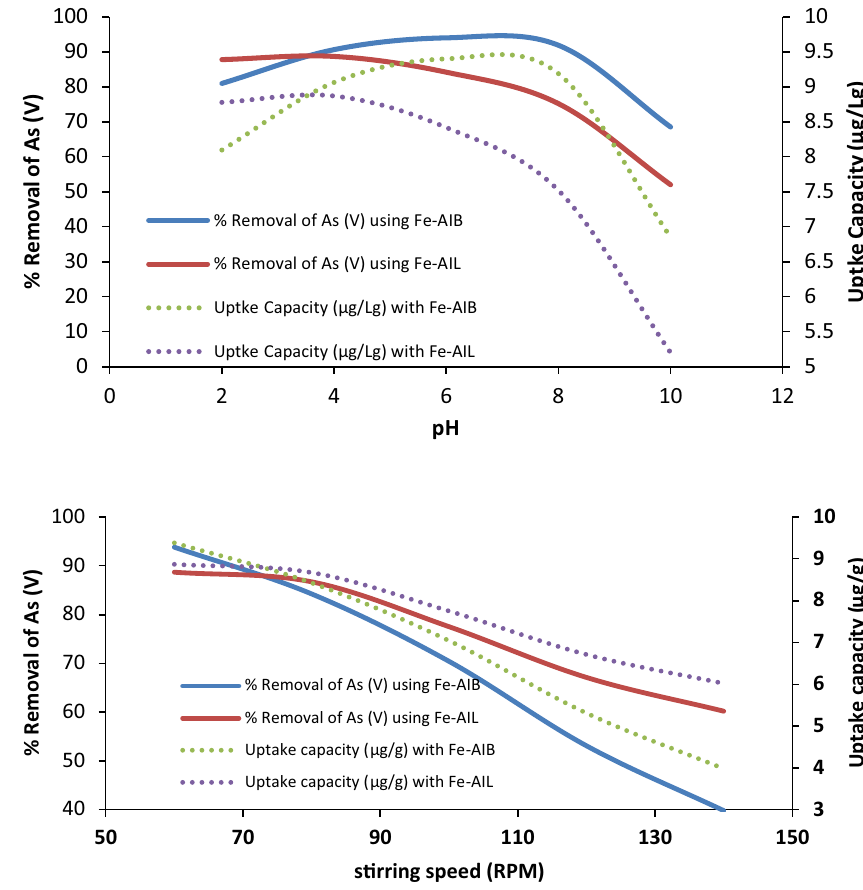
Fig. 11 Effect of pH on adsorp- tion of As (V) by Fe-AIB and Fe-AIL